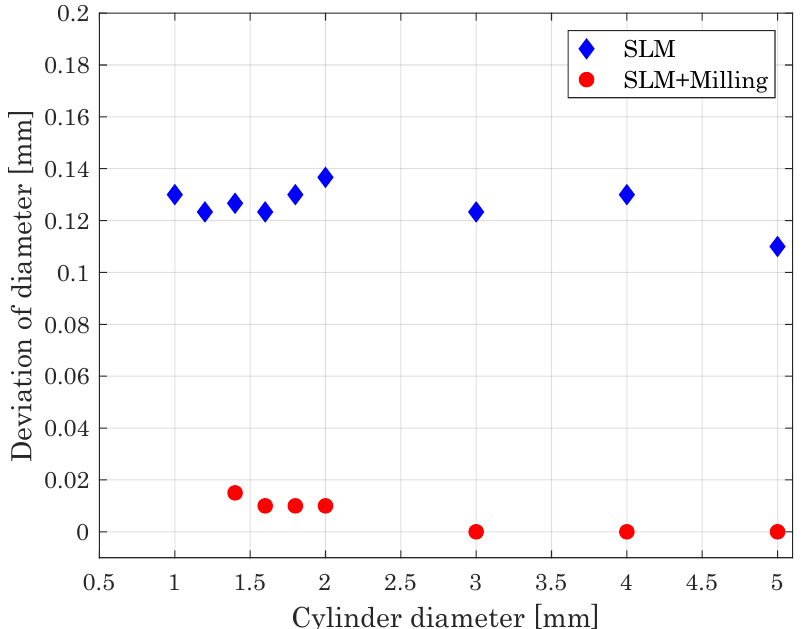
Figure 12. Deviation of cylinder diameter versus intended cylinder diameter, giving a measure of the dimensional accuracy of the